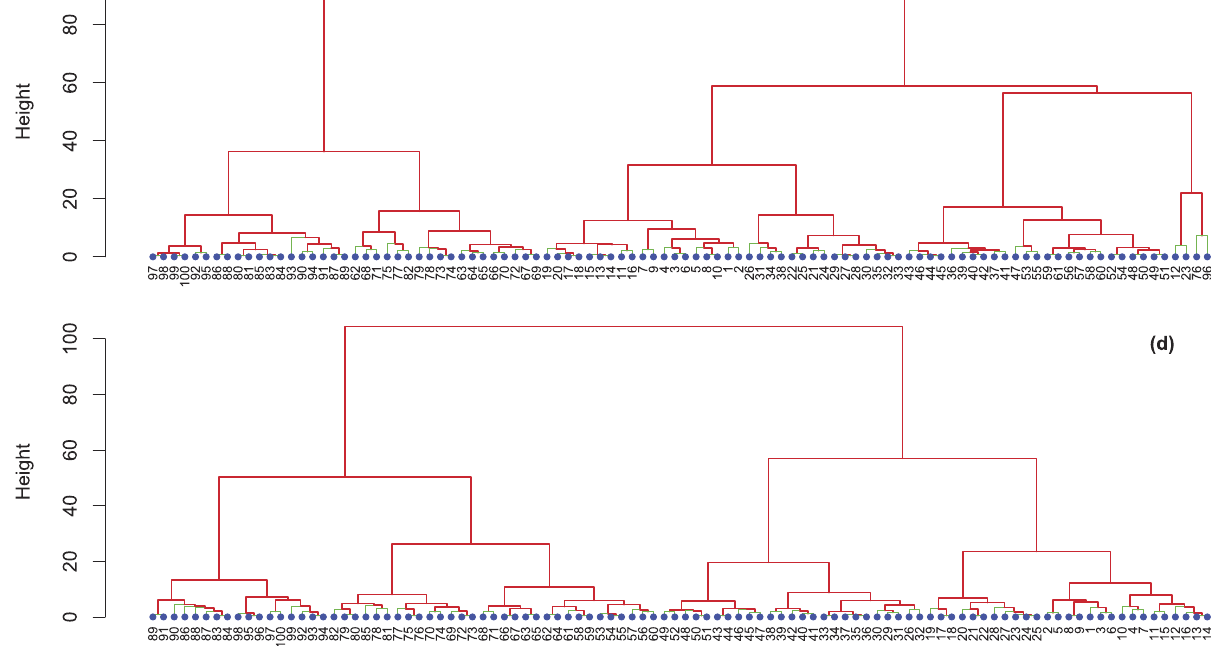
PLOS Computational Biology | https://doi.org/10.1371/journal.pcbi.1006714 January30, 2019 15 /